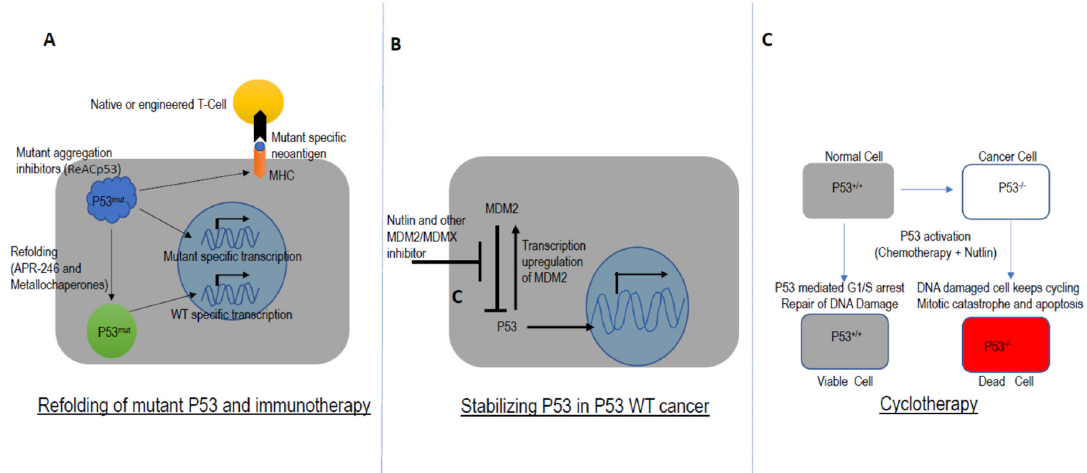
Figure 7. Targeting P53 in Drug Development. ( A ) APR-246 and similar compounds refold mutant P53 into wild-type-like conformation. Some P53 mutants are prone to aggregation and ReACp53 inhibits this aggregation. Mutant P53 can be presented on the surface of cancer cells as a neoantigen, providing an opportunity for the development of immunotherapy. ( B ) In P53 WT cancer cells, nutlin and other MDM2/MDMX inhibitors promote the accumulation and activity of WT P53. ( C ) Cyclotherapy protects normal cells from genotoxic agents. Nutlin arrests WT P53 containing normal cells, while P53 mutant cancer cells continue cycling and die due to accumulation of DNA damage.